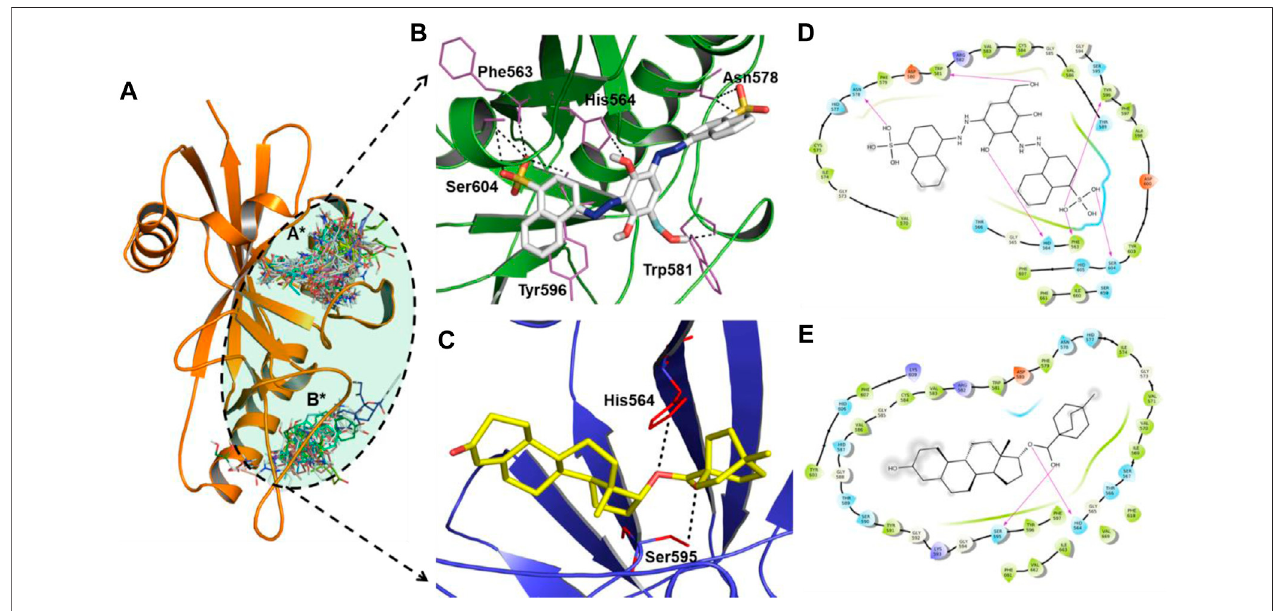
FIGURE 2 | (A) Close-up view of the binding pockets (A* and B* encircled by black dotted lines) of the PARP12 enzyme. H-bond interactions between (B) ZINC03830332 (white stick), (C) ZINC03831186 (yellow stick), and PARP12 receptor (in green and blue color cartoon models). (D,E) 2D plot of the complexes.